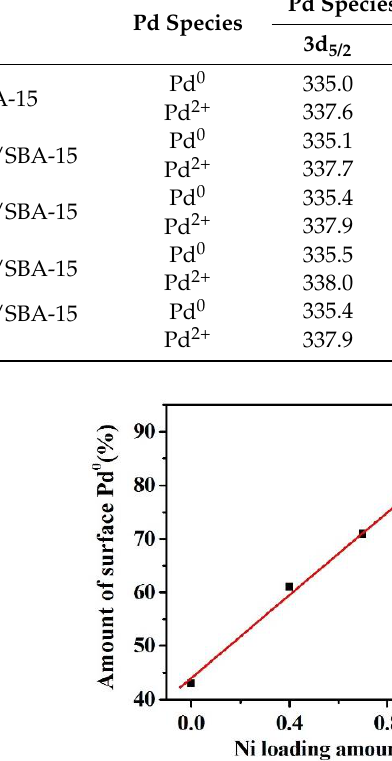
Figure 5. XPS spectra of ( A ) Pd3d and ( B ) Ni2p of the catalysts (a) 0.2%/SBA-15, (b)